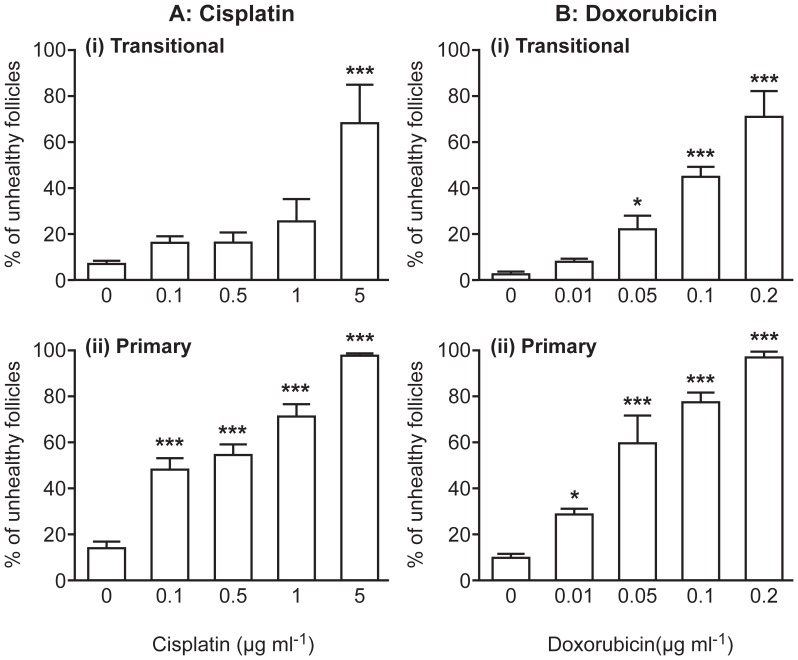
Cisplatin and doxorubicin affect different follicle classes.Follicles were classified as morphologically unhealthy in cisplatin and doxorubicin treated ovaries according to follicle type. Effect of (A) Cisplatin or (B) Doxorubicin on the percentage of transitional and primary follicles classified as morphologically unhealthy. Bars denote mean+sem; n = 5 for all groups, stars denote significant differences relative to control (*p<0.05, **p<0.01, ***p<0.001).